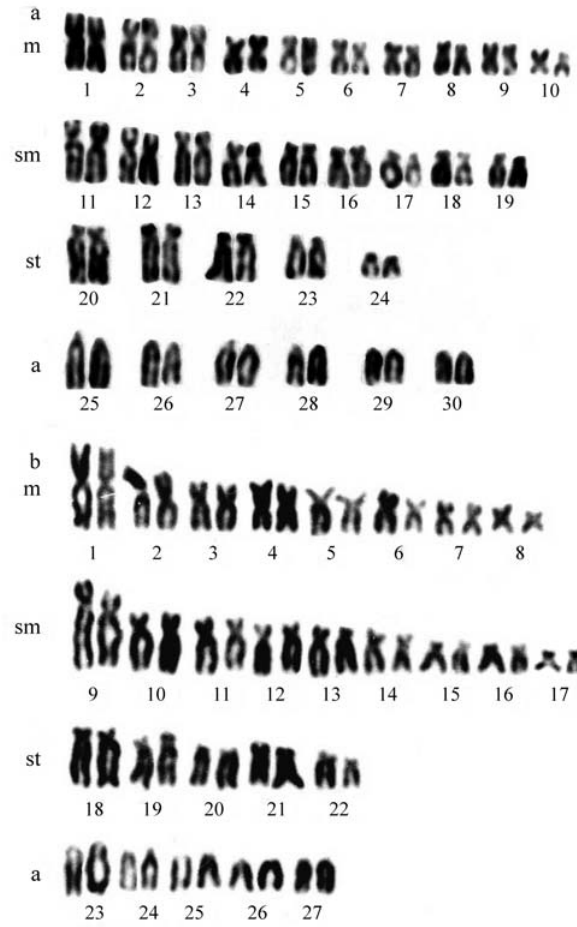
Figure 1 - Conventional Giemsa stained karyotypes of (a) Conorhynchus conirostris , and (b) Lophiosilurus alexandri